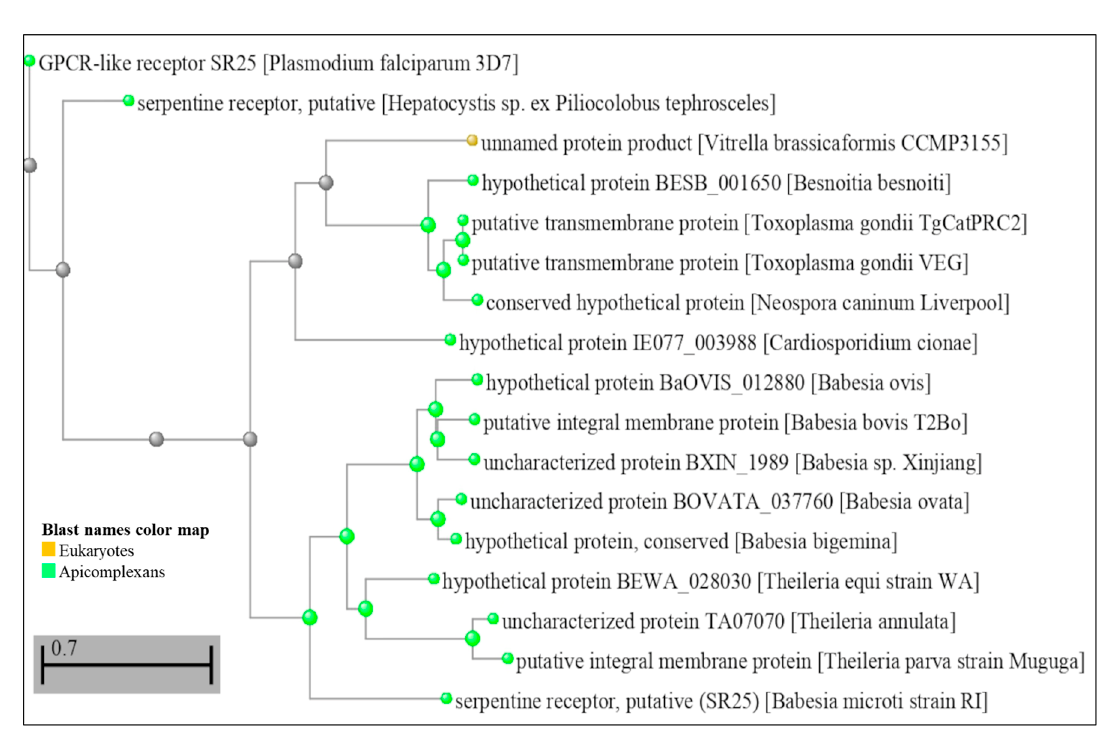
Figure 2. Dendrogram showing amino acid sequence comparison of PfSR25 (PF3D7_0713400) with other sequences from the US National Library of Medicine database—National Center for Biotechnol- ogy Information (NCBI—https://blast.ncbi.nlm.nih.gov/Blast.cgi accessed on 6 February 2023). A search was performed on the BLAST platform that resulted in significant alignment sequences; these data were later used to build a distance tree from the results performed on the platform itself [45,46]. (Scale bar 0.7 amino acid substitutions).